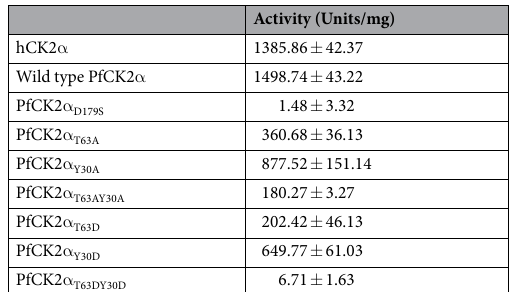
Table 2. PfCK2 α variants activity measurements using the peptide [RRRDDDSDDD] as phosphate acceptor for the incorporation of radiolabelled [ γ 32